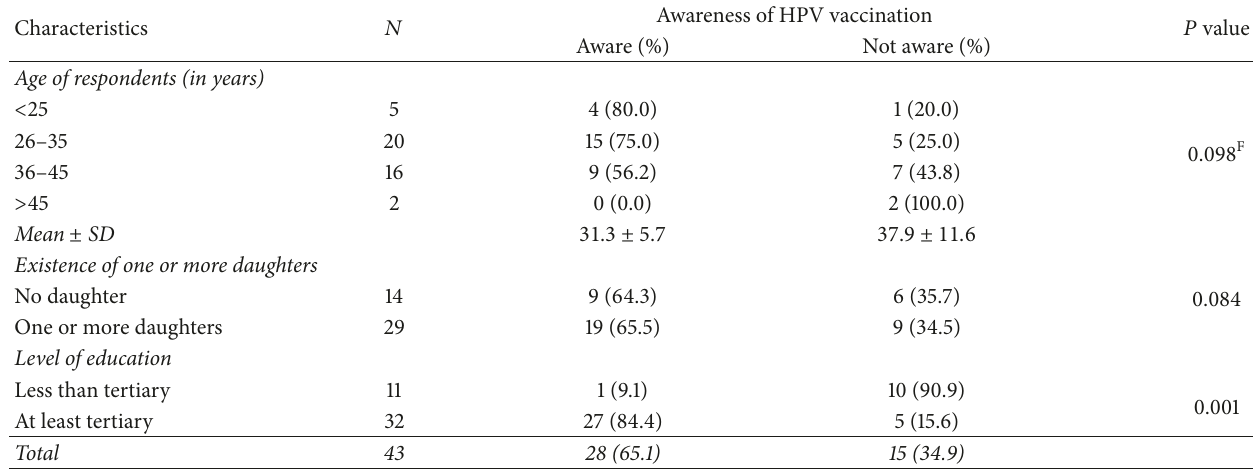
Table 3: Association between sociodemographic characteristics and awareness of HPV vaccination among respondents with correct knowledge of HPV infection ( 𝑛 = 43 ).